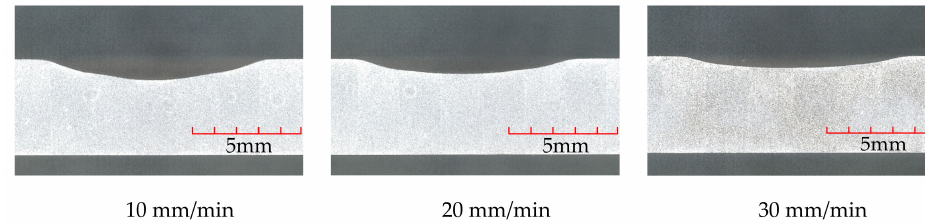
Figure 8. Cross-sectional photographs of machined grooves under different feed rates.